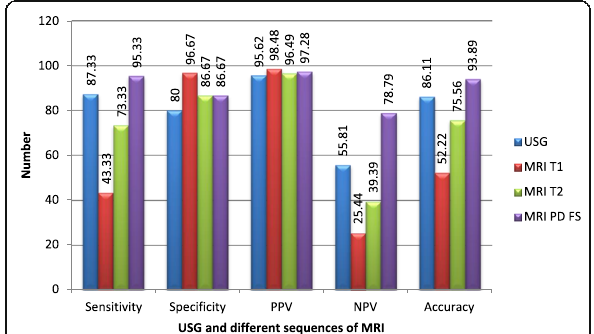
Fig. 3 Diagnostic value of HRUS and different sequences of MRI on the basis of the study